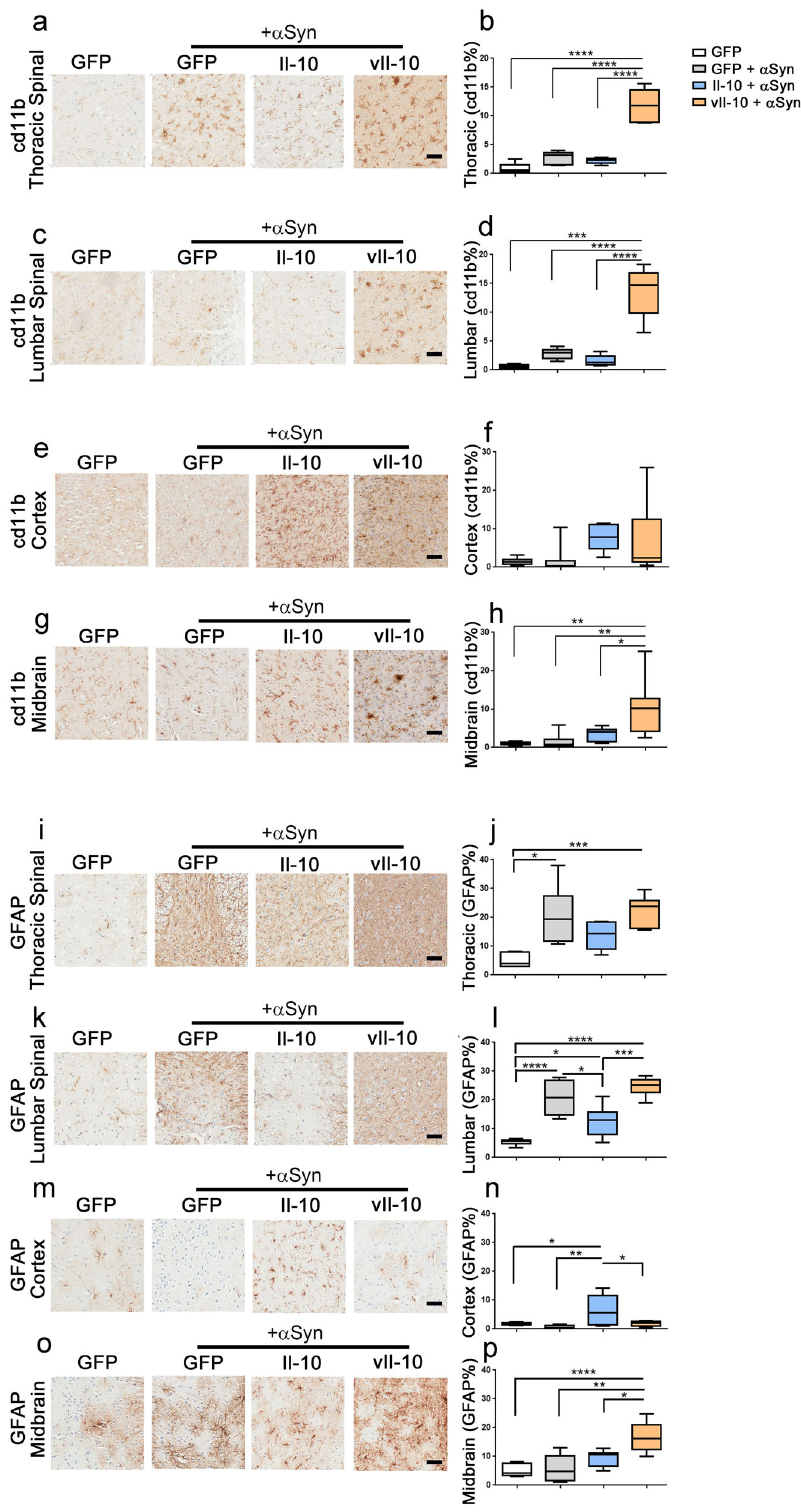
(Fig. 4a, b, P < 0.0001 against all groups in the thoracic segment; Fig. 4c, d, P < 0.001 against control and P < 0.0001 against α Syn- seeded mice in the lumbar segment). While vIl-10 expression also enhanced microgliosis in the midbrain area (Fig. 4g, h; P < 0.05 compared to Il-10-expressing α Syn-seeded mice and P <